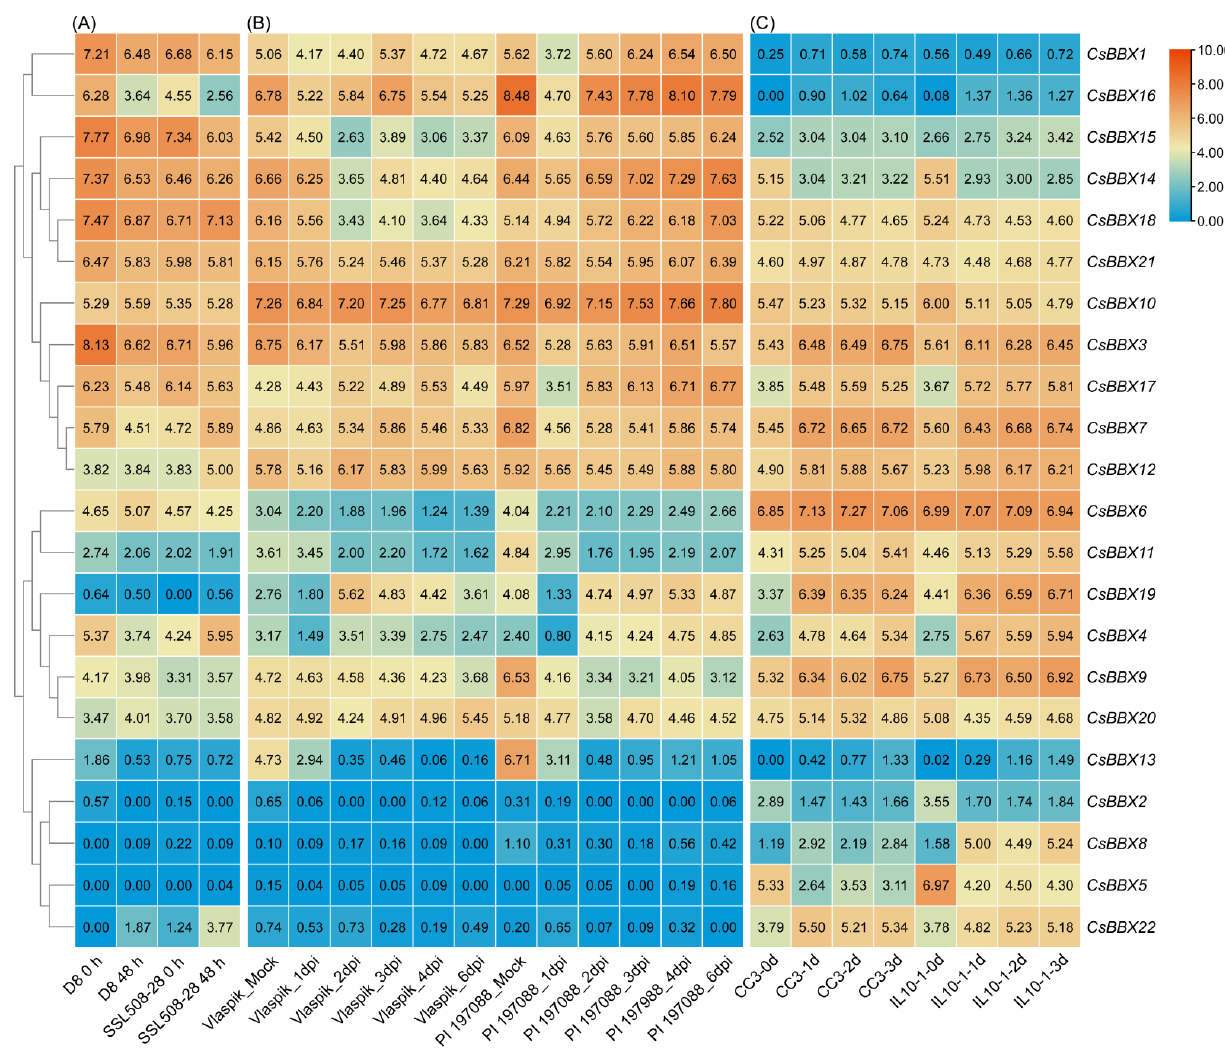
Figure 9. Expression profiles of CsBBX genes in cucumber inoculated with PM ( A ), DM ( B ), and RKN ( C ). ( A ) Expression of CsBBX genes in response to PM treatment in cucumber cultivars D8 (PM-susceptible) and SSL508-28 (PM-resistant). ( B ) Expression of CsBBX genes in Vlaspik (DM- susceptible) and PI 197088 (DM-resistant) cultivars of cucumber after DM inoculation. Mock, control sample. ( C ) Expression of CsBBX genes at different time points after infection with M. incognita in a RKN-susceptible line (CC3) and RKN-resistant line (IL10-1). The expression data were displayed and clustered with TBtools using log 2 (TPM + 1) values; dpi, days after